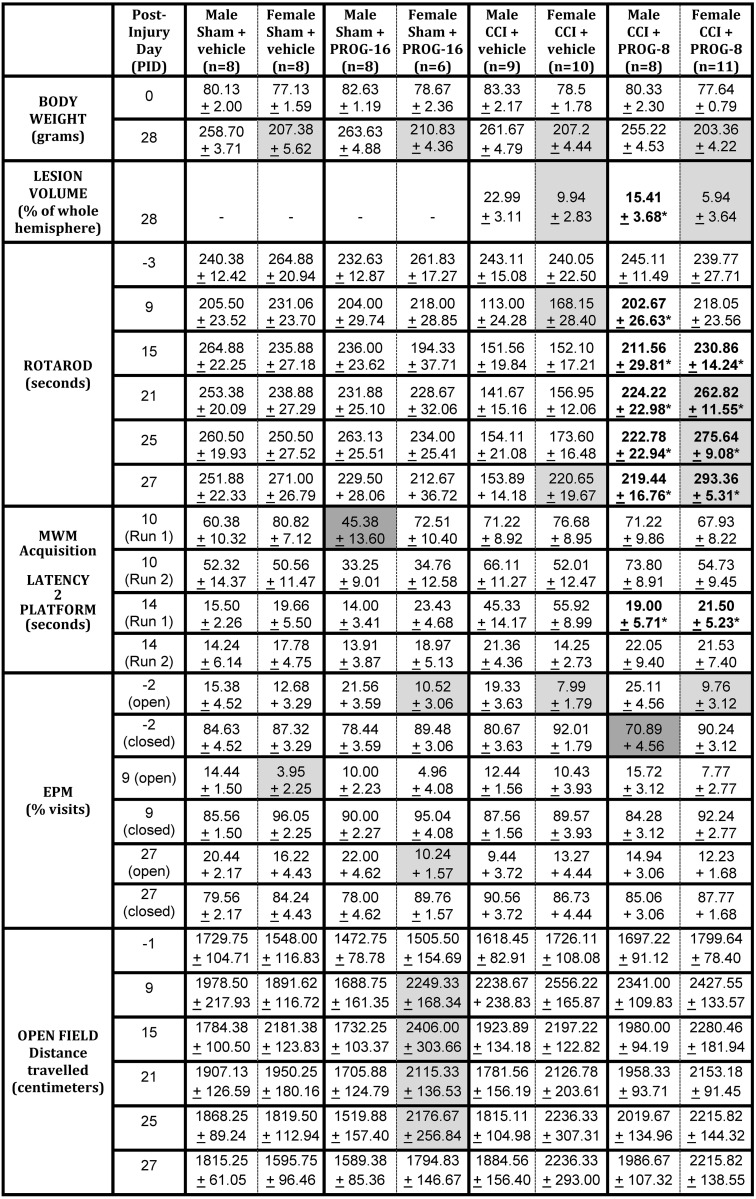
Tabulated comparative deficits between male and female controlled cortical impact injury.Bold numbers with asterisk (*) indicate differences between treatment groups within the same gender, p < .05. Darker-shaded cells indicate where male rats either found the hidden MWM platform faster or made fewer visits to the closed arm of the EPM than similarly treated female rat pups (between-gender analysis), p < .05. Lighter-shaded cells indicate where female rat pups either weighed less, had smaller lesions, spent less time in the open arm of the EPM, tended to travel longer distances (Open Field), remained on the rotarod longer, or found the MWM platform faster than similarly treated male counterparts (b/w gender analysis), p < .05; PID 0 = day of injury but prior to surgery; PID -1 = day(s) before surgery; MWM: Morris Water Maze; CCI: controlled cortical impact; Mean +/- SEM; n = 6–11. Male data (columns 3, 5, 7, and 9) were previously published [26].